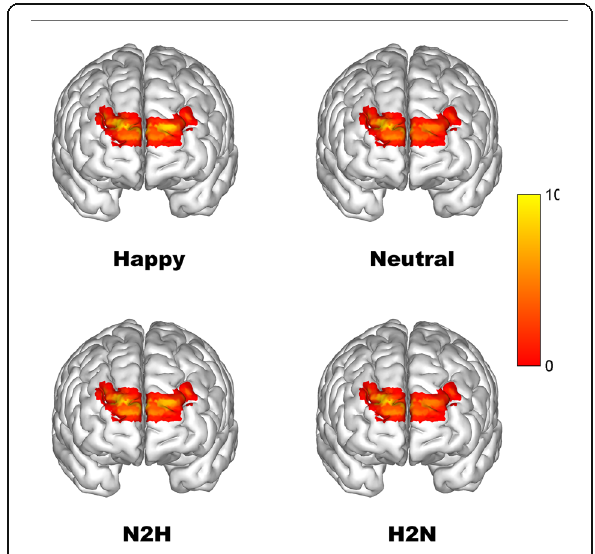
Fig. 8 The brain activation maps of various conditions at a frequency of 0.2 Hz. The values are